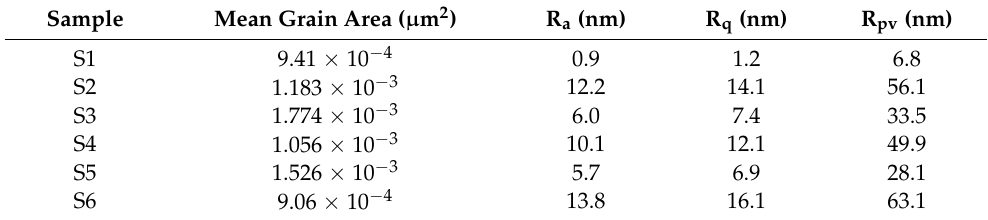
Table 3. Topographic data of S1–S6